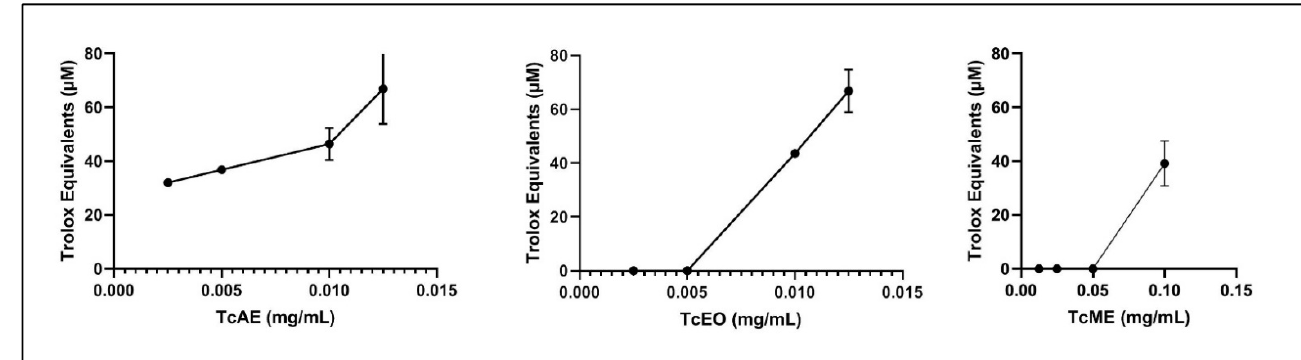
Figure 4. Antioxidant activity of methanolic, acetonic extracts, and essential oil of T hymus capitatus by the ORAC method. by the ORAC